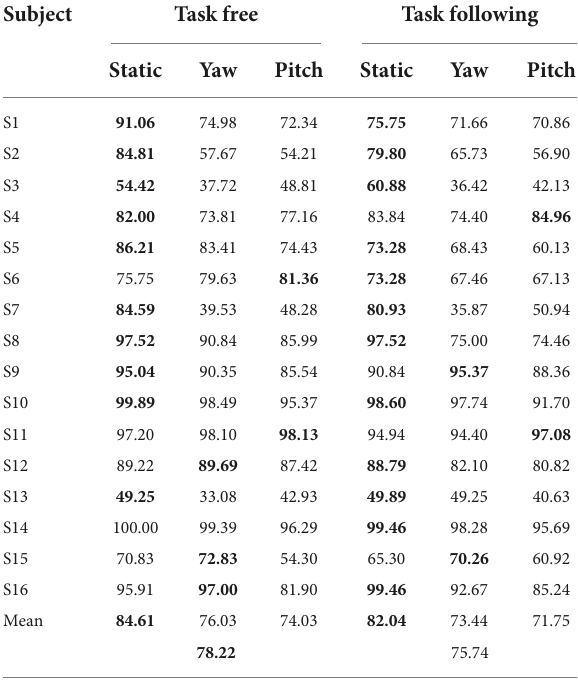
TABLE 1 The canonical correlation analysis classification accuracy of sixteen subjects under all the conditions in using the 2 s epoch